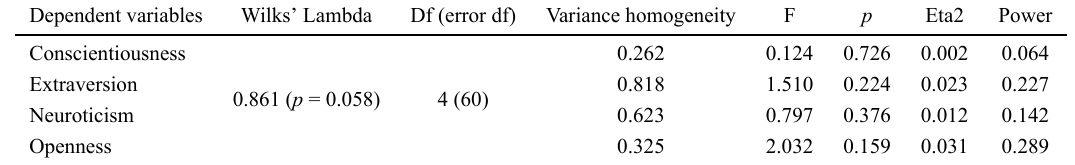
Table 4. Multivariate analysis of variance results for personality characteristics by